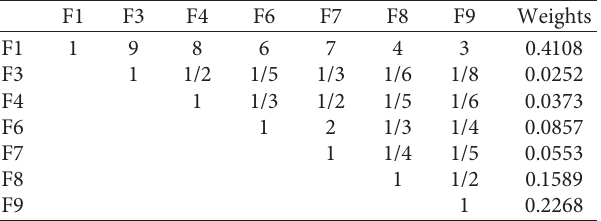
Table 3: Pairwise comparison matrix and relative importance weights of the factors associated with wind energy.